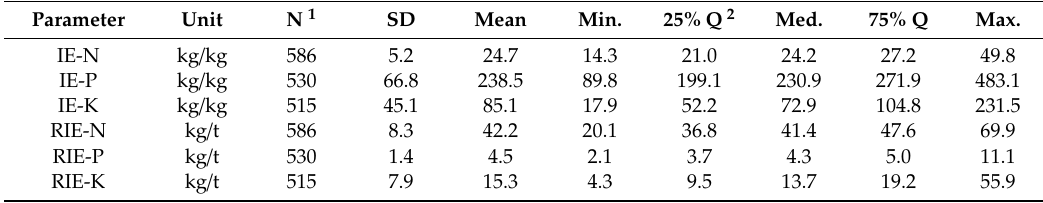
Table 2. Internal e ffi ciency (IE, kg pod / kg nutrient) and reciprocal internal e ffi ciency (RIE, kg nutrient / t pod) values of N, P, and K in China’s peanut crops from 1993 to